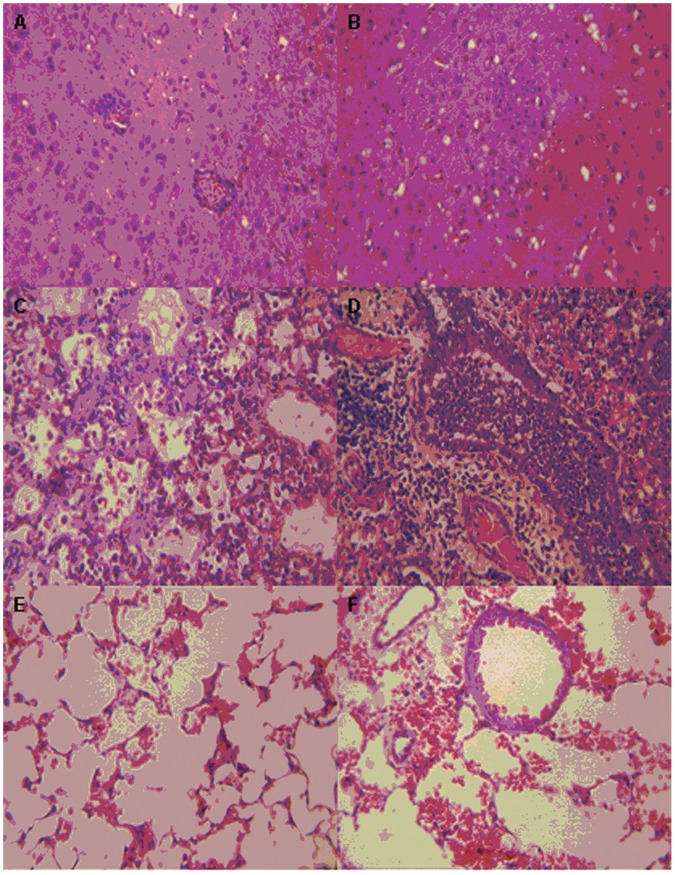
Representative photomicrographs of hematoxylin-andeosin-stained tissues from ducks and mice inoculated with H5N2 viruses.(A) Perivascular lymphoplasmacytic cuffs around a few cerebral vessels in the cerebrum of a mallard duck infected with DK/EC/1111/11 and euthanatized on 5 dpi. (B) Small foci of gliosis in the cerebrum of a mallard duck infected with GS/EC/1112/11 and euthanatized on 5 dpi. (C and D) Mild pneumonorrhagia in the lung of BALB/c mice infected with DK/HB/0908/09 (C) and CK/HB/1102/10 (D), on 5 dpi. (E and F) Mild to severe pneumonorrhagia with lymphohistiocytic alveolitis in the lung of BALB/c mice infected with DK/EC/1111/11 (E) and GS/EC/1112/11 (F), on 5 dpi.